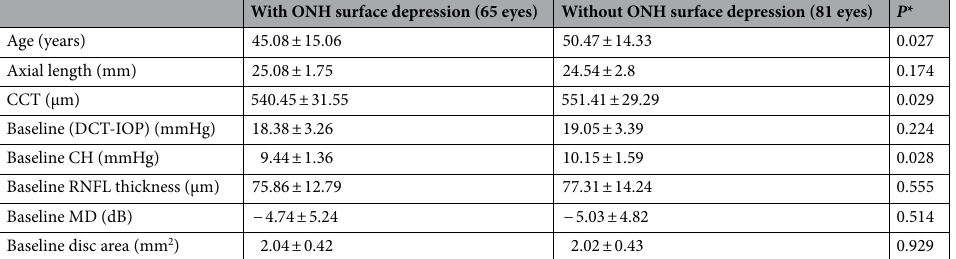
Table 2. Comparisons of baseline ocular biometry, visual field, optic nerve head (ONH), retinal nerve fiber layer (RNFL), corneal hysteresis (CH) and intraocular pressure (IOP) measurements (DCT-IOP) between eyes with and without optic nerve head (ONH) surface depression with CSLO. CCT—central corneal thickness; DCT-IOP—diastolic intraocular pressure; MD—mean deviation; CH—corneal hysteresis. *Comparisons were performed using Linear mixed